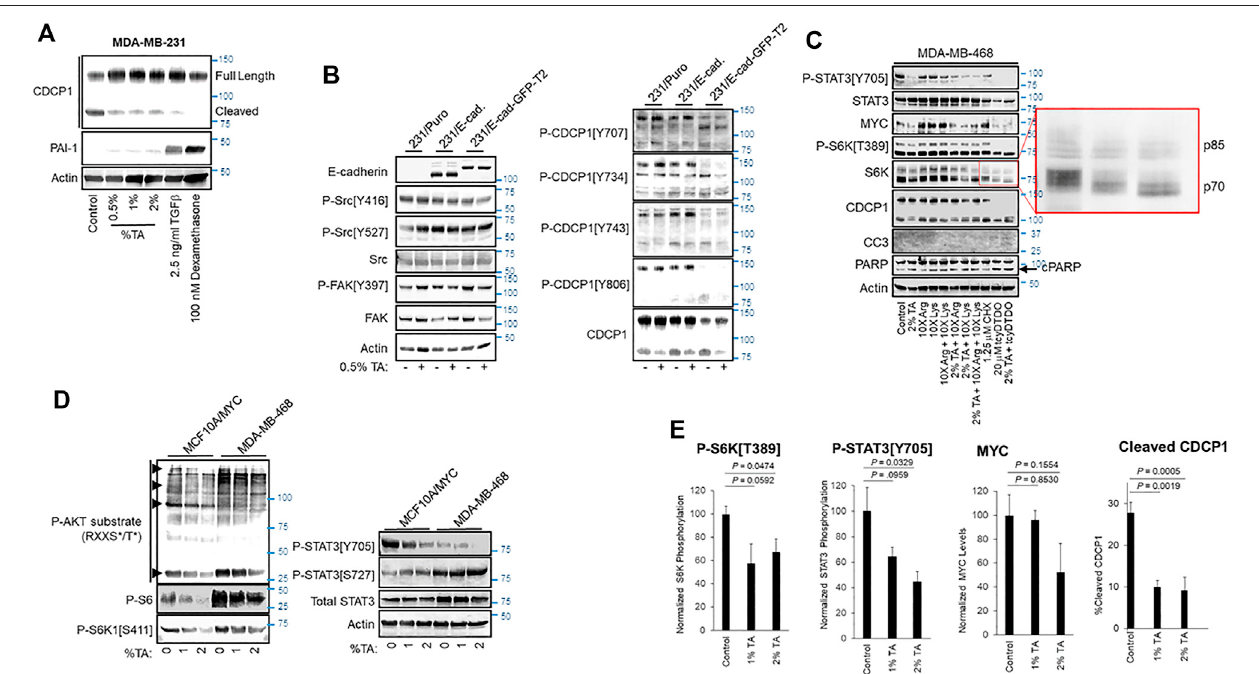
FIGURE 2 | TA blocks CDCP1 cleavage, reduces MYC expression, and decreases STAT3 and S6K1 phosphorylation. (A) MDA-MB-231 cells were treated as indicated for 24 h and cell extracts were subjected to immunoblot analysis. (B) Vector control MDA-MB-231 cells or cells overexpressing E-cadherin (E-Cad.) or an E-cadherin-Green Fluorescent Protein fusion (E-Cad-GFP) were treated for 24 h with vehicle or 0.5% TA and cell extracts were subjected to immunoblot analysis. (C) MDA-MB-468 cells were treated for 24 h as indicated and subjected to immunoblot analysis. As indicated Lys and/or Arg were present in some treatments at 10X theconcentrationpresentinDMEM.Theexpandedredboxshowsalteredmobilityduetodifferentialphosphorylationofthep70andp85isoformsofS6K1.NotethatTA combinedwithtcyDTDOreducedS6K1phosphorylationmorethanthatobservedwithtcyDTDOalone.Inhibitionofproteinsynthesiswith1.25 μ MCycloheximide(CHX) reduced STAT3 tyrosine phosphorylation, but did not alter MYC levels, S6K1 phosphorylation, or CDCP1 cleavage. (D) Immunoblot analyses examining the effects of treating MYC overexpressing MCF10A cells or MDA-MB-468 cells for 24 h with 1 or 2% TA on STAT3 Ser and Tyr phosphorylation, S6K1 phosphorylation on Ser 411 , phosphorylationoftheS6K1substrate,S6,andphosphorylationofproteinsonconsensusphosphorylationsitesforAKT.NotethattheAKTconsensusphosphorylation sequence overlaps with that of S6K1. (E) Quantitation of the effects of 24 h treatment of MDA-MB-468 cells with 1% or 2% TA on S6K1 phosphorylation, STAT3 phosphorylation, MYC expression levels, or CDCP1 cleavage across multiple experiments. Results are the average of six replicates and presented as the average ± S.E.M. p -values were calculated using an unpaired Student ’ s t